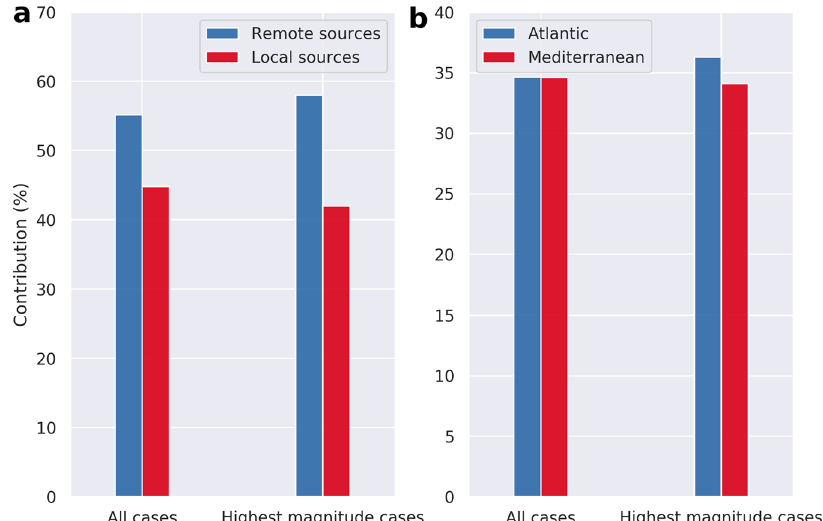
Fig. 2 Comparison between remote and local contributions. a Total contribution from remote sources (blue) versus local sources (red) averaged for all cases studied (left) and for the 25 highest magnitude cases (right). b Same comparison but for the Atlantic Ocean versus the Mediterranean